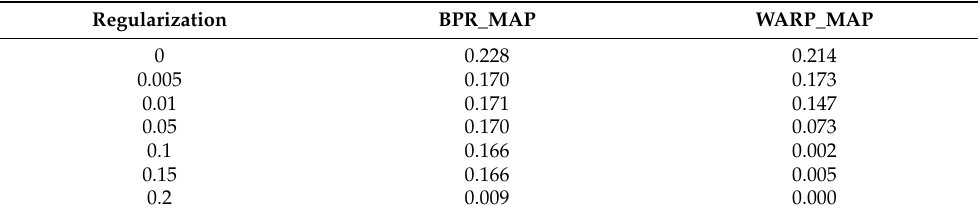
Table 3. Regularization parameter tuning. This table presents MAP@10 for different parameter values. The remaining parameters are set to the default values according to Table 1.